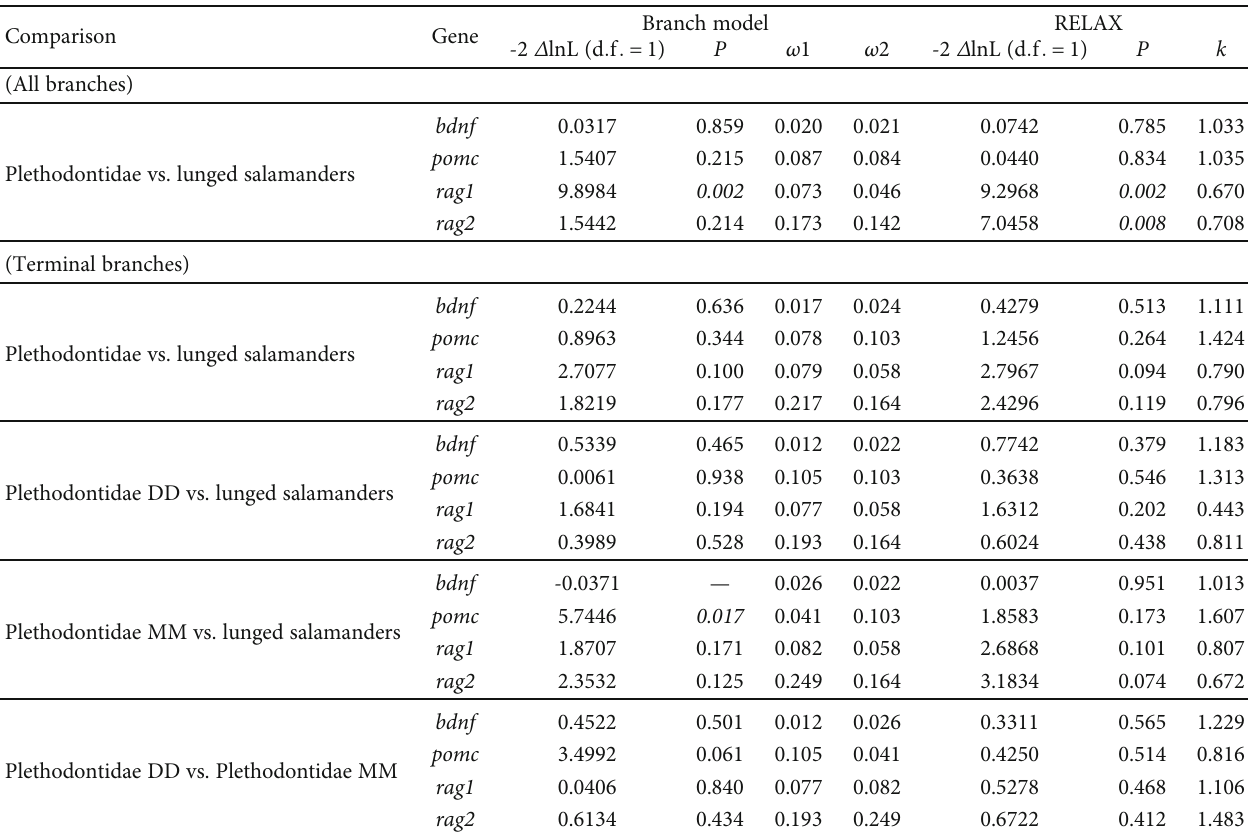
Table 3: Results of branch model and RELAX analyses of nuclear